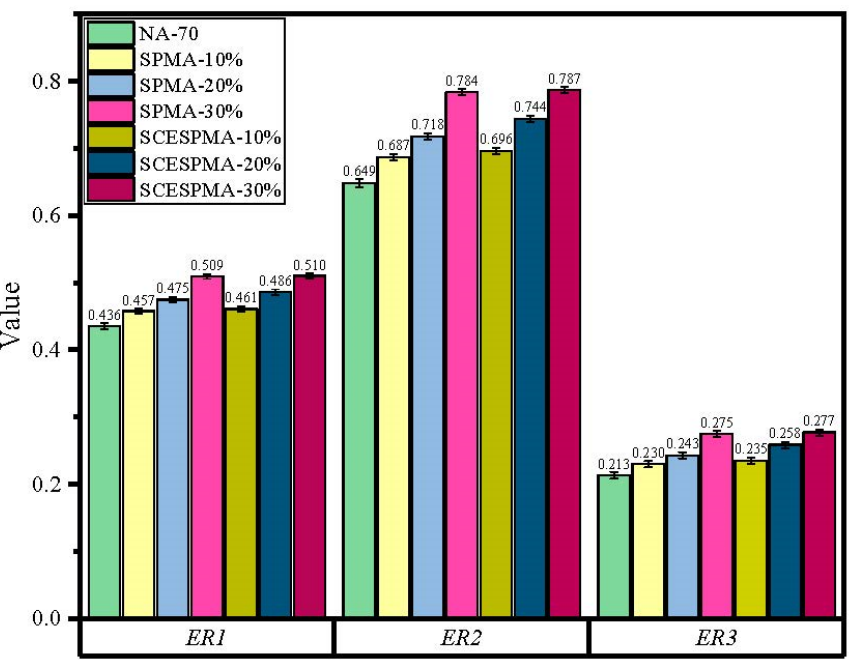
Figure 18. Comprehensive water stability evaluation parameters of SPMA and SCESPMA.